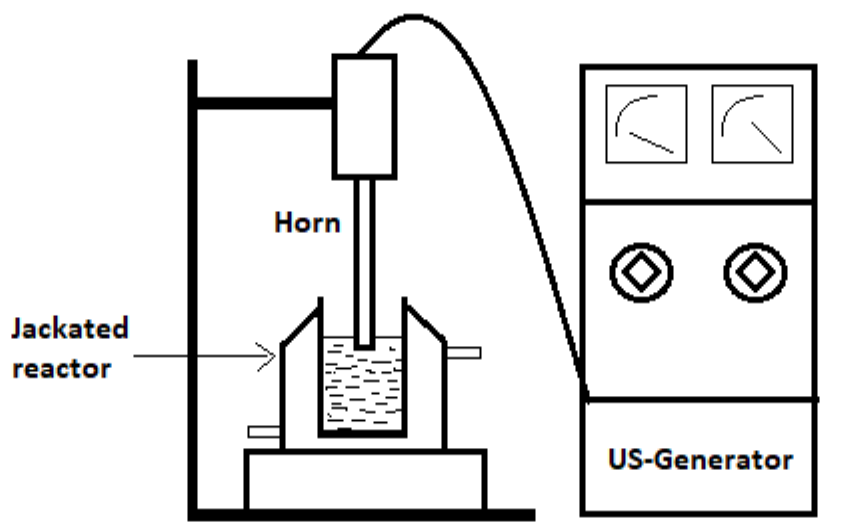
Figure 11. Schematic representation of ultrasonic horn used for catalyst synthesis and dye degra- dation.